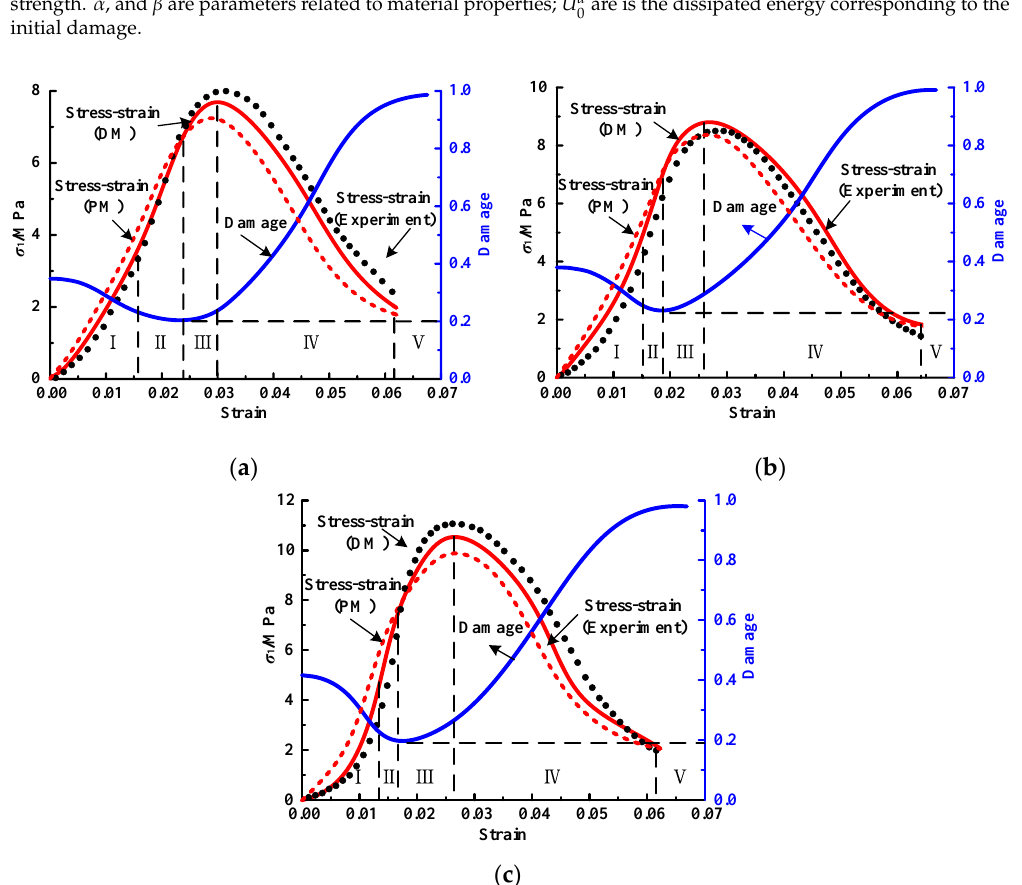
Table 5. Parameters of damage constitutive model of cement mortar specimens.